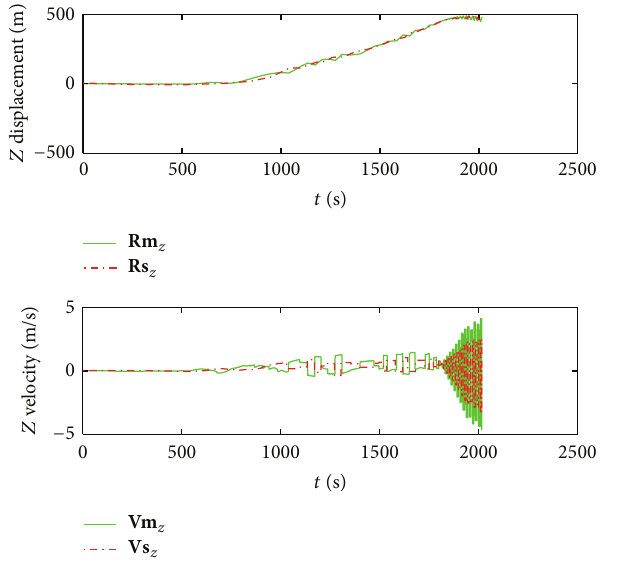
Figure 19: The out-plane positions and velocities of the ROGER (m) and abandoned (s)